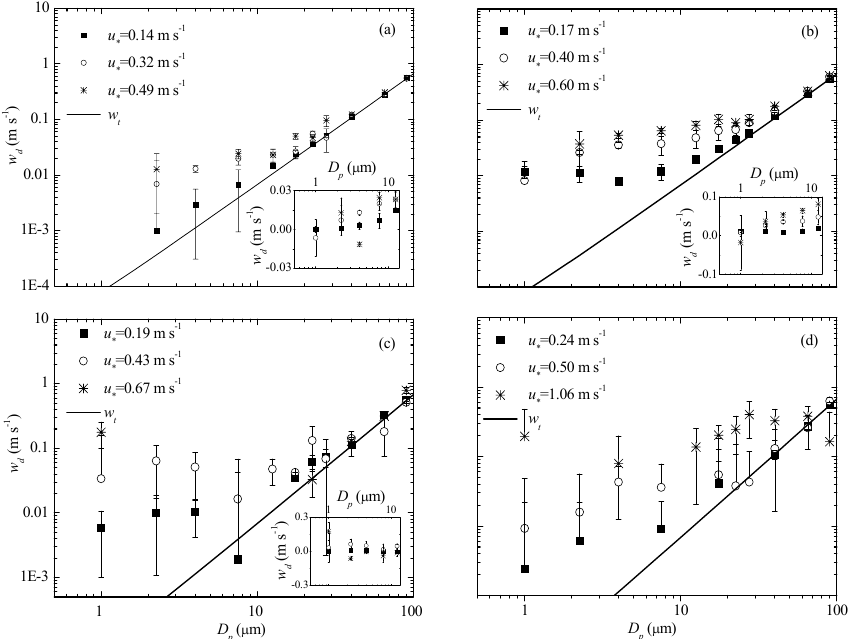
Figure 12. As Fig. 10, but for (a) sand, (b) sandy loam, (c) gobi, and (d) tree surface. For the tree surface, the measurement height is z m =